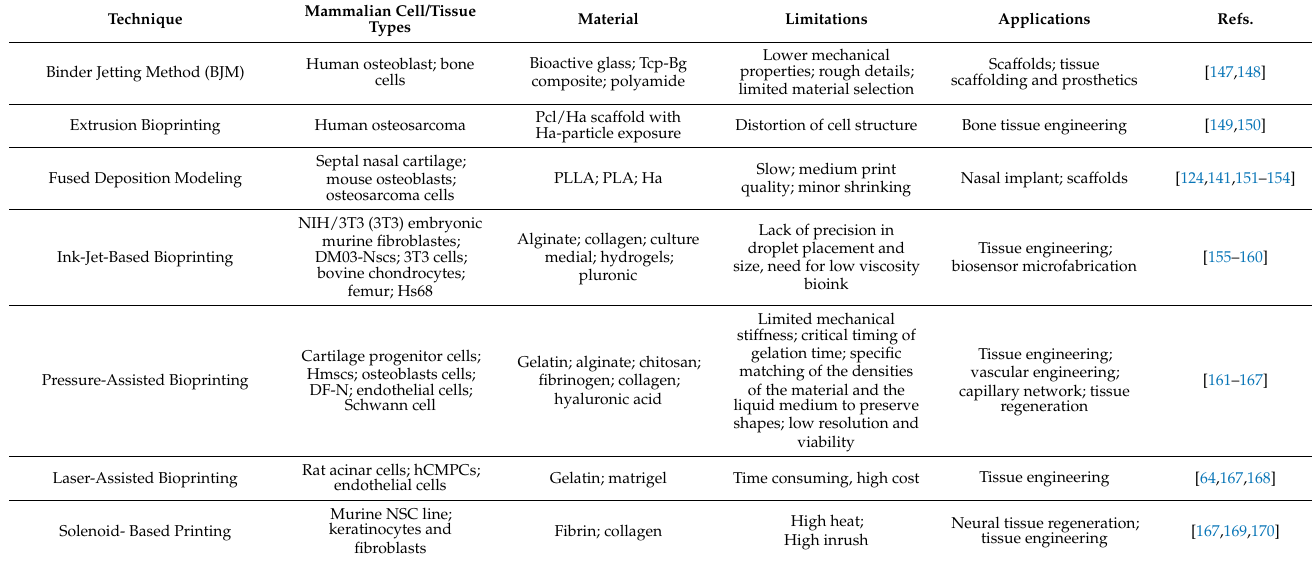
Table 7. Relevant examples of 3D bioprinting techniques and